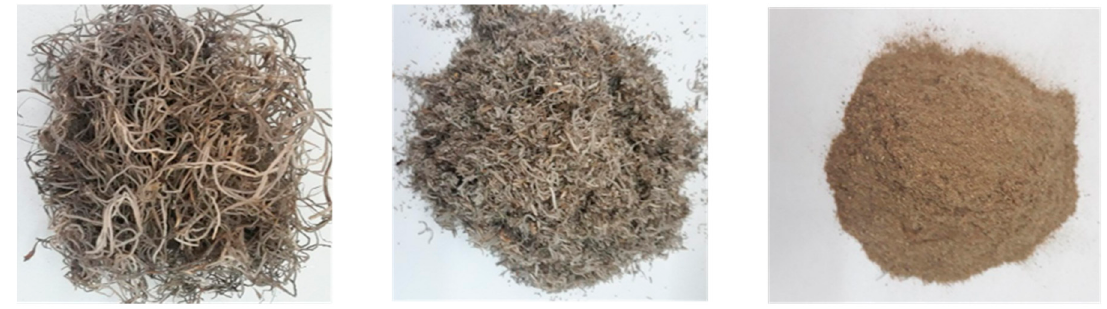
Figure 5. The lichen U. barbata used in this study. Whole (left); Macerated (middle); Powder (right).